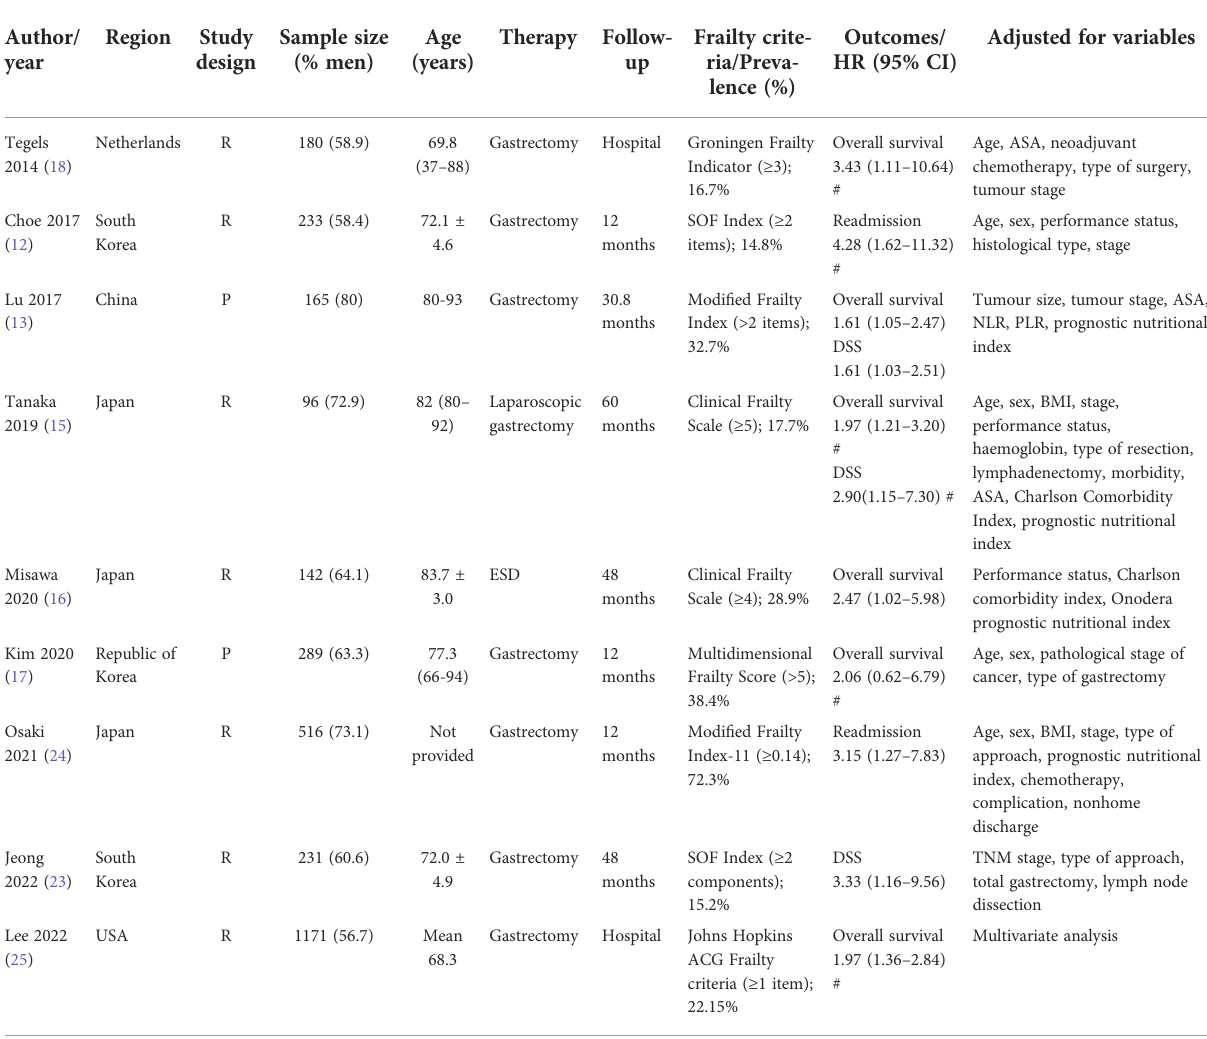
TABLE 1 Main characteristics of the included